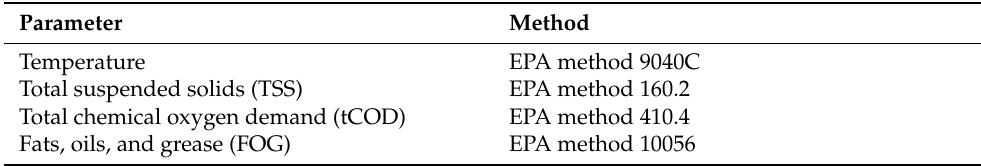
Table 4. Sample Analysis